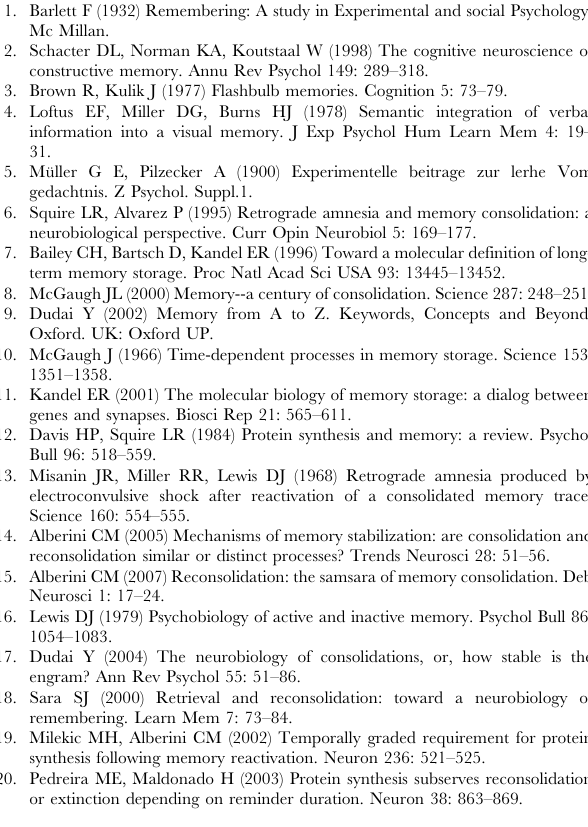
Figure S1 Learning curves. Mean number of errors + / 2 SEM per trial on Day 1. On the first trial the List is presented for the first time. A) Experiment 1A. Black dots stand for the Group R c , white triangles stand for the Group R c x2, white square for the Group R c x4. Inset. Mean number of total errors in the four last actual trials. Black bar stands for Group R c , white bar for Group R c x2 and stripe